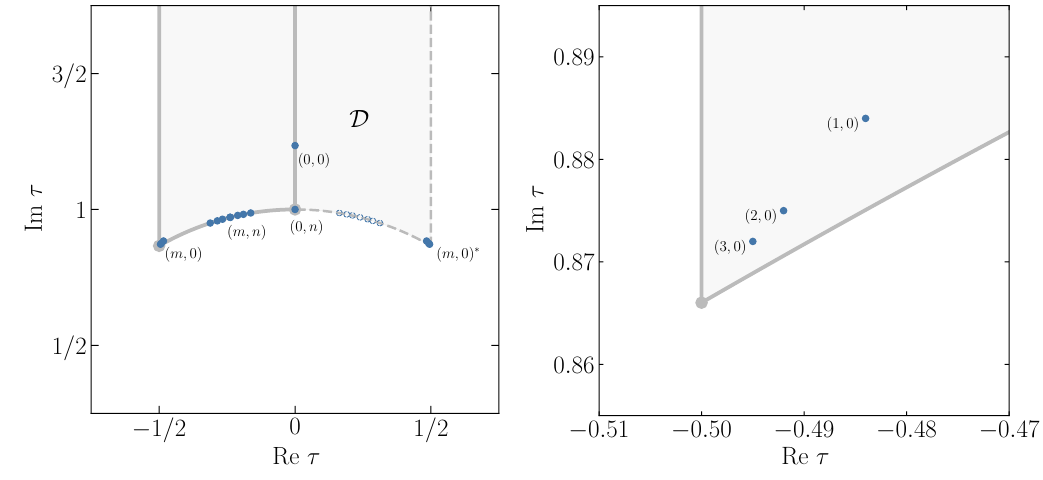
Figure 2 . Global minima of the potentials V ( τ, ¯ τ ) , eq. (2.12), see text for details. Note that points on the right half of the unit arc, which are CP-conjugates of the ( m, n ) minima, are excluded as they lie outside the fundamental domain. The right panel shows the series ( m, 0) in the vicinity of the left cusp in more